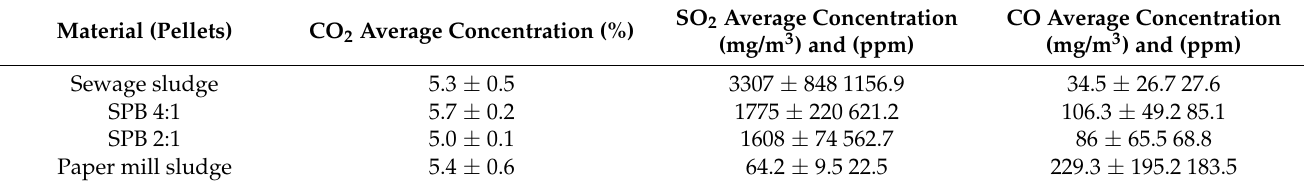
Table 4. Average concentrations of carbon dioxide, carbon monoxide, and sulphur dioxide in the flue gas.